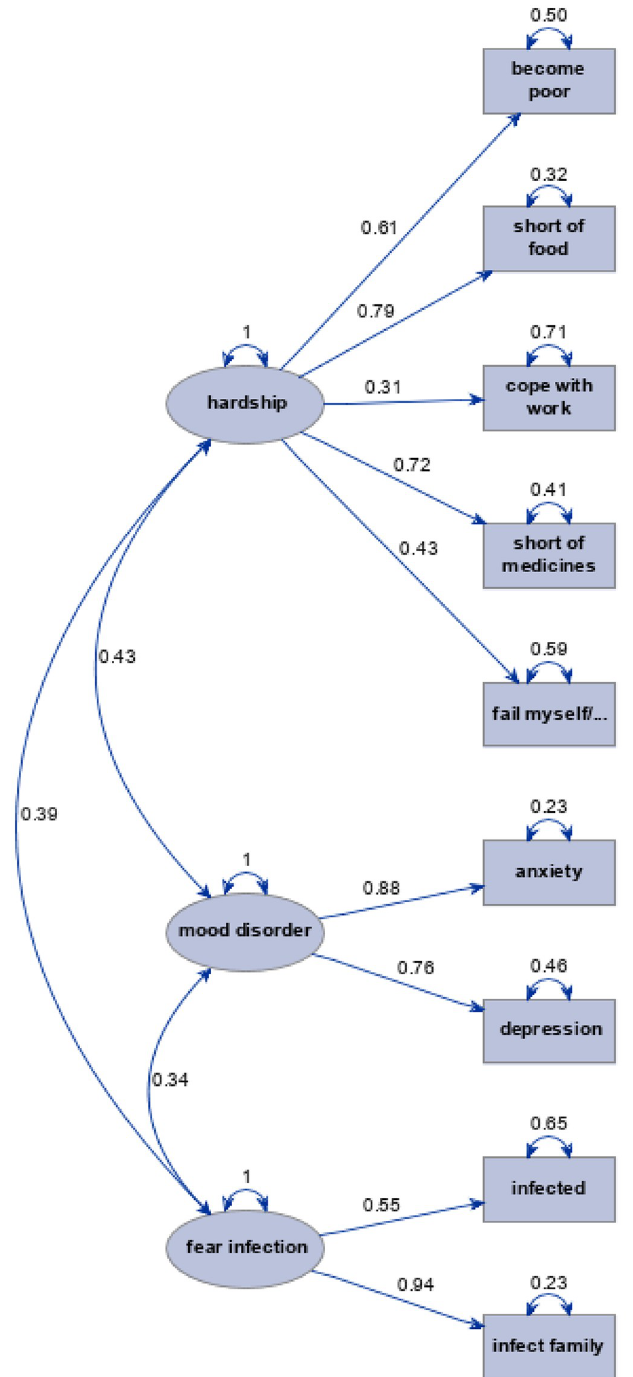
Fig 2. Directed paths with loadings greater than 0.3, p < 0.001: Inter-relation of HADS scores and specific worries.